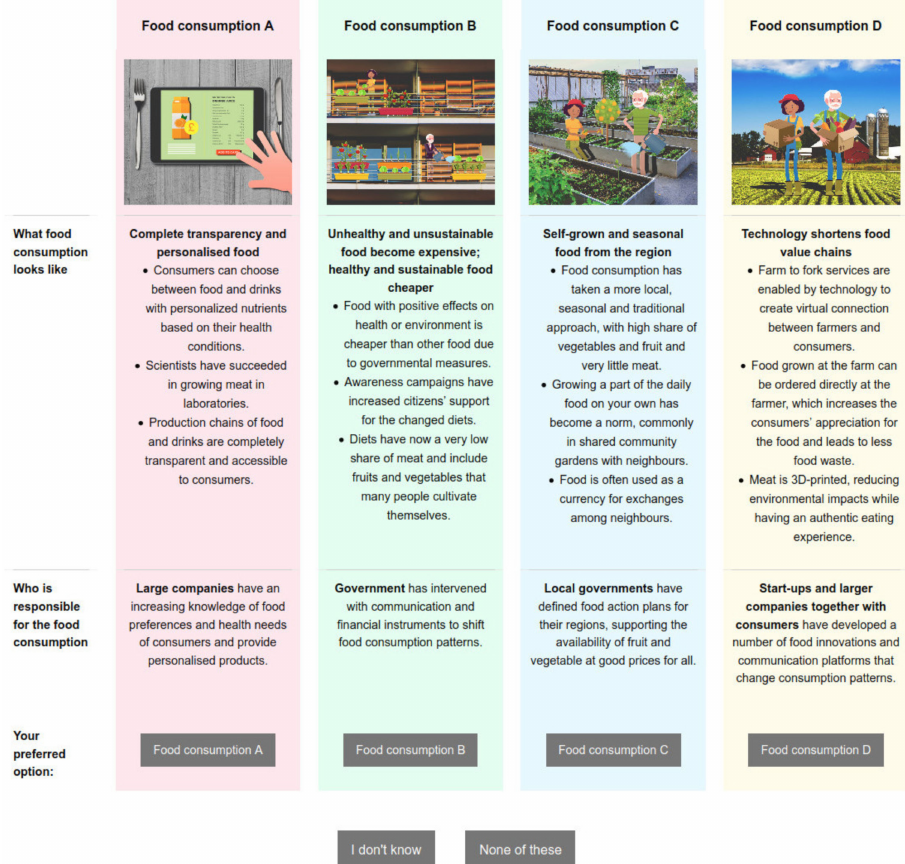
Figure A4. Example of a choice card—INHERIT scenarios, food consumption domain (Food consumption A corresponds to the “My life between realities” scenario, Food consumption B to the “Less is more to me” scenario, Food consumption C to the “One for all, all for one” scenario, and Food consumption D to the “Our circular community”